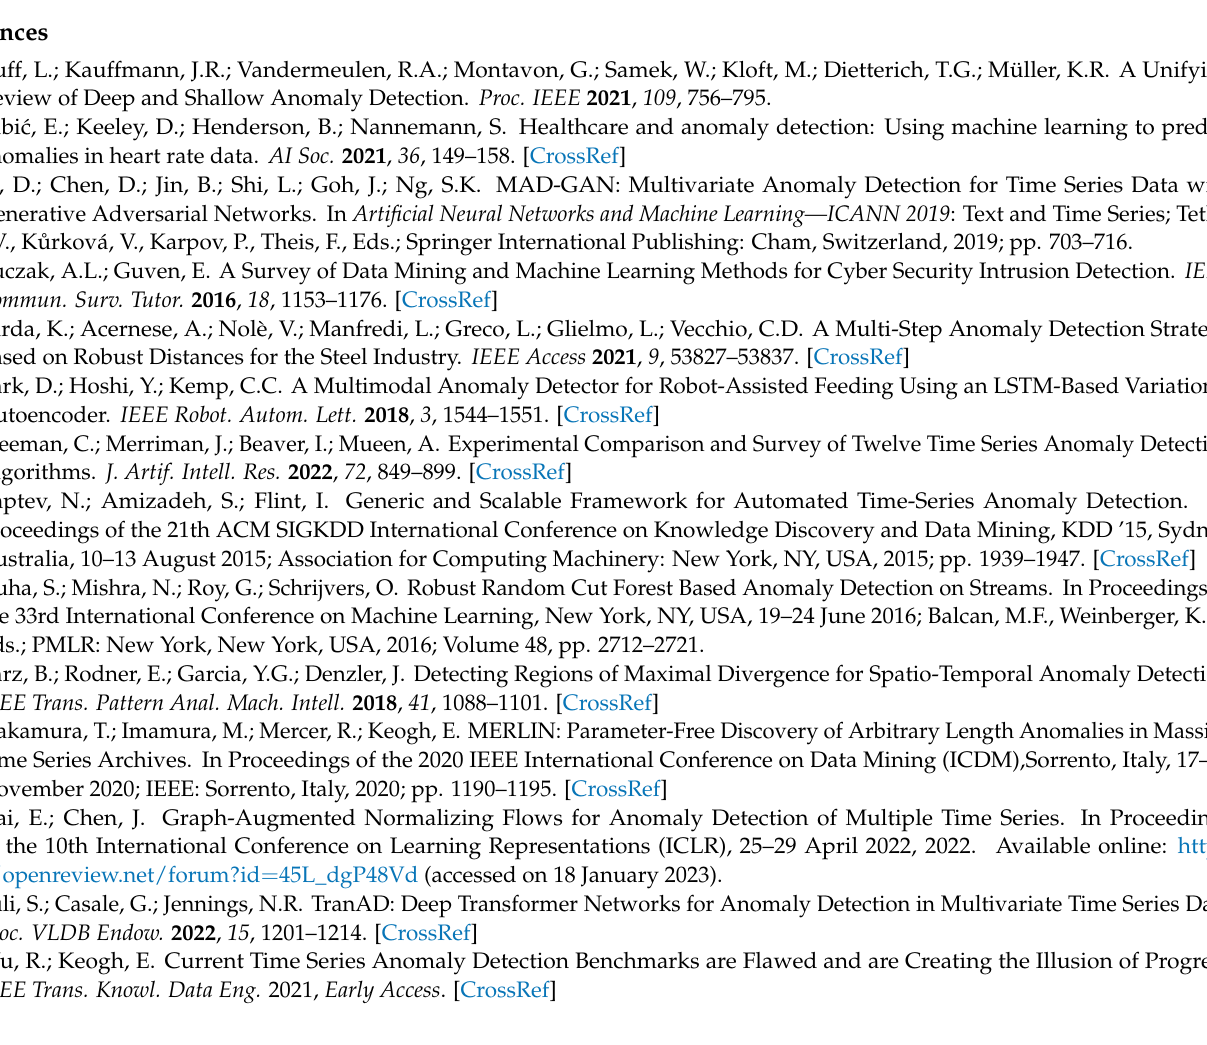
Figure A1. The heatmaps show the standard deviation for AUC ROC, F1 Score and UCR Score over six repetitions of the experiment. Next to the anomaly type, the number of times series containing it is shown in parenthesis. The respective macro-averaged mean values can be found in Figure